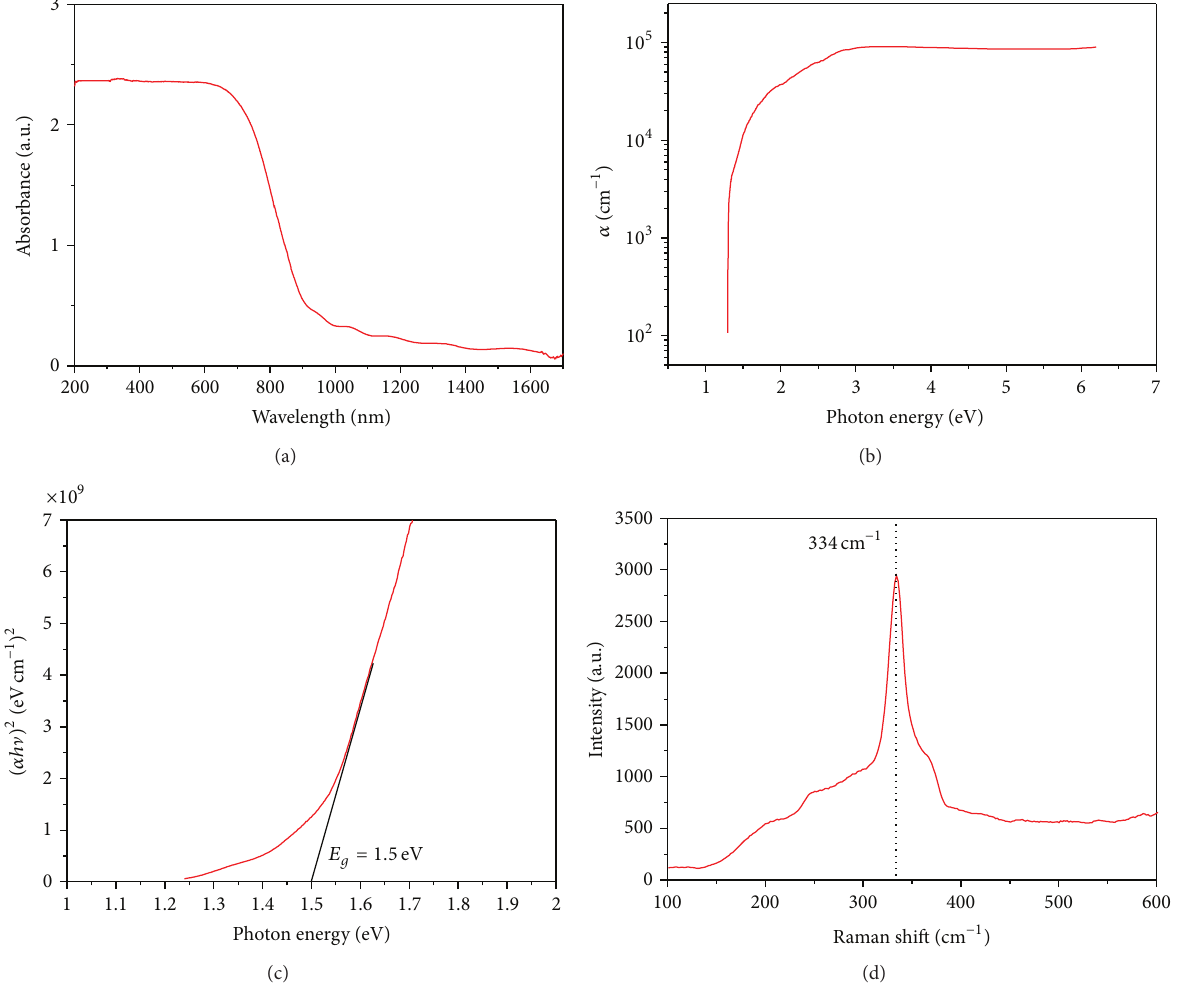
Figure 5: Optical properties of CZTS thin film annealed in sulfur vapor at 530 ∘ C; (a) absorbance, (b) optical absorption coefficient, (c) optical band gap (1.5eV), and (d)